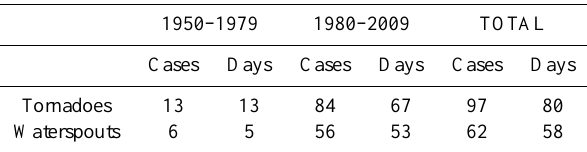
Table 1. Number of tornadoes and waterspouts (and number of days in which one or more tornadoes and waterspouts have been observed) for the two subperiods